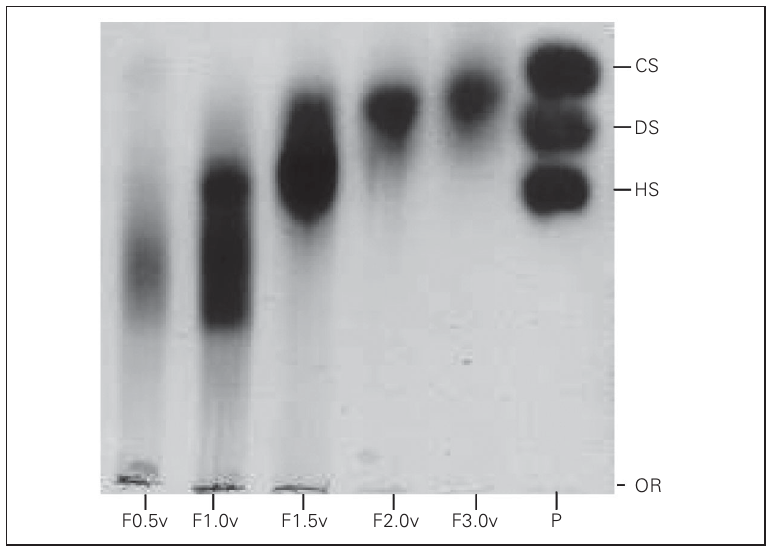
Figure 1. Diaminopropane acetate electrophoresis of the heterofucan fractions. Five- milliliter aliquots of the fractions shown were applied to agarose gel (7.5 x 10 cm, 0.2-cm thick) prepared in 0.05 M 1,3-diaminopropane-acetate buffer, pH 9.0, and subjected to electrophoresis at 110 V/cm for 60 min. The gels were then maintained in 0.1% cetyltri- methylammonium bromide for 4 h and dried, and the polysaccharides were stained with 0.1% toluidine blue in a solution containing 50% ethanol and 1% acid acetic in water for 15 min. The gels were then destained with the same solution without toluidine blue. P, 10 µg each of heparan sulfate (HS), dermatan sulfate (DS), and chondroitin sulfate (CS). F0.5v, F1.0v, F1.5v, F2.0v, F3.0v = fucans precipitated with 0.5, 1.0, 1.5, 2.0 and 3.0 acetone volumes. OR =